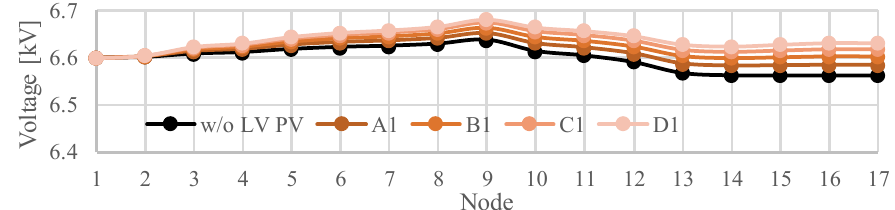
Figure 10. Time variation in voltage at MV distribution feeder with PCS for which the power factor is Figure 11. Voltage profile in MV distribution feeder (power factor is set to 1.0).